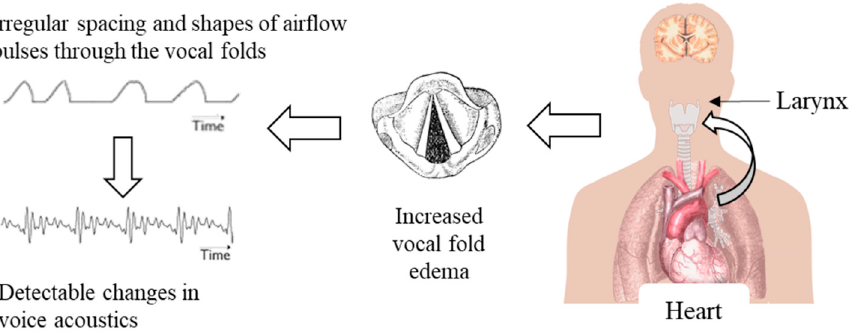
Figure 1. Hypothesized effects of HF-related congestion on laryngeal edema, voice airflow, and properties of the acoustic voice signal, whose features have the potential to be detectable earlier than systemic increases in body weight.